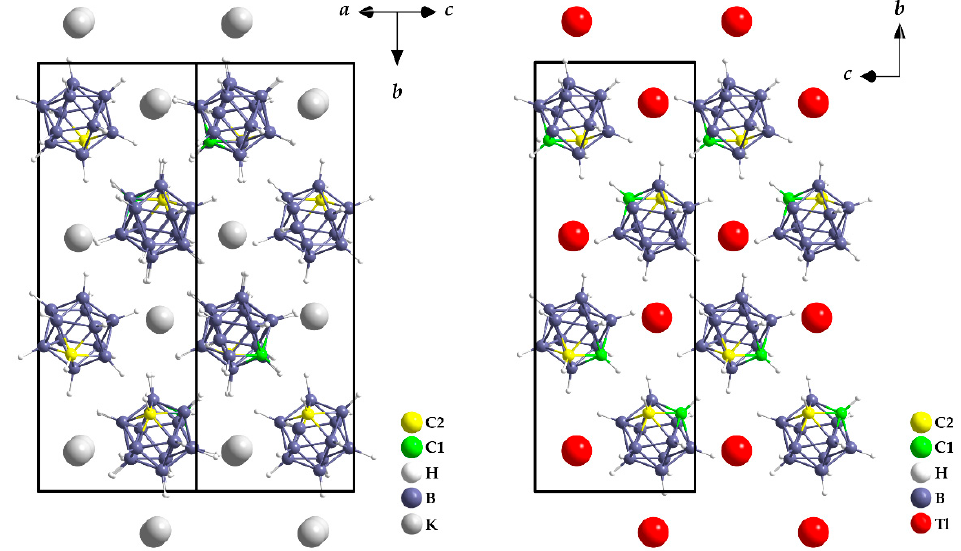
Figure 6. Comparison of the ordered K[CB 11 H 12 ] (left) and the disordered Tl[CB 11 H 12 ] structure (right), showing that the determined positions of C1 and C2 are the same for both monoclinic arrangements after superimposition.